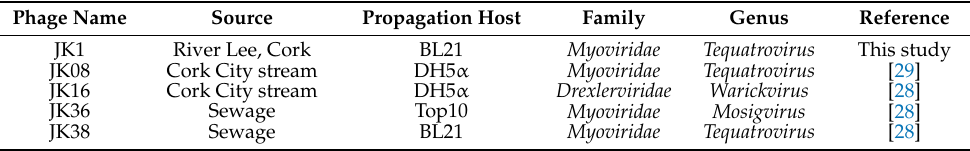
Table 1. Characteristics of the phages applied in this